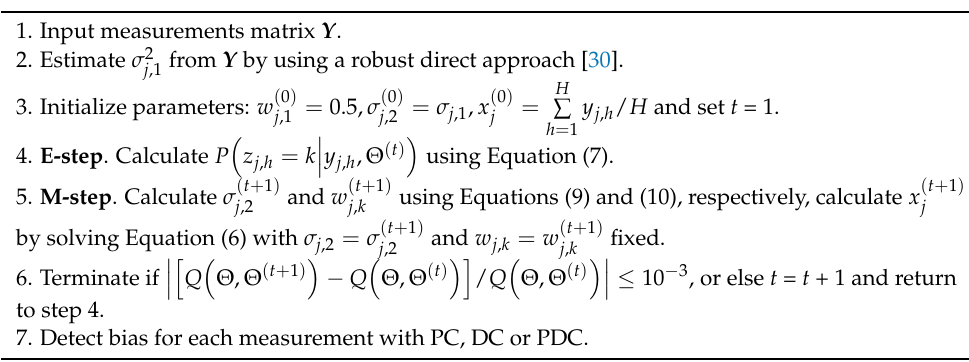
Table 1. Modified expectation maximization (EM) approach for data